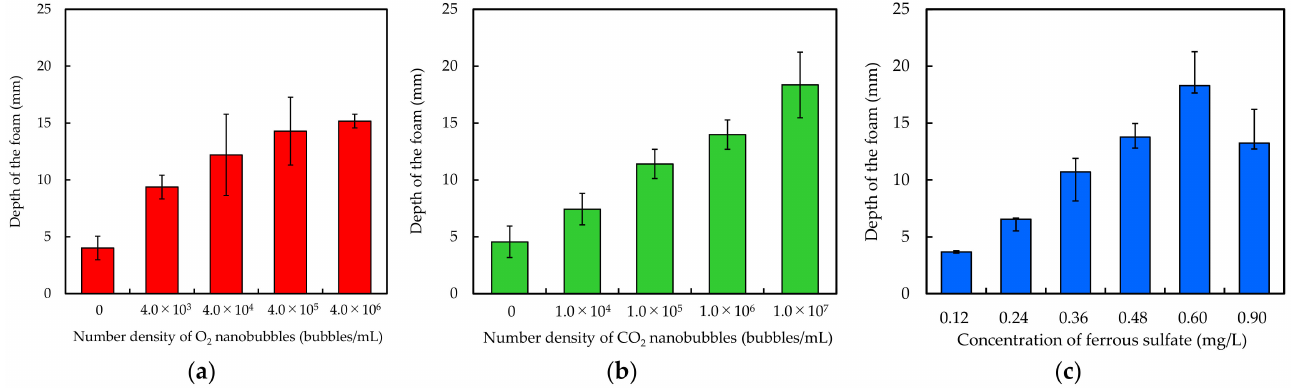
Figure 4. The depth of the foam phase observed in each culture medium after 72 h of P. aeruginosa cultivation: ( a ) the oxygen nanobubble medium; ( b ) the carbon dioxide nanobubble medium; ( c ) the ferrous sulfate-enriched